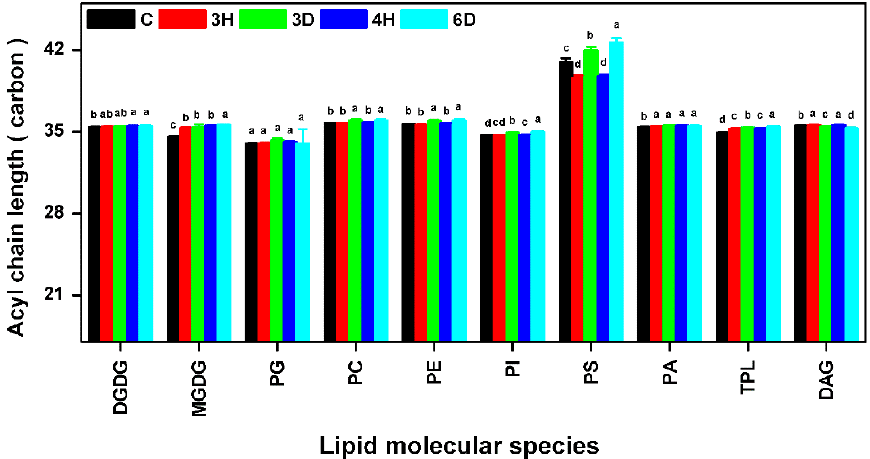
Figure 9. Acyl chain lengths (ACLs) of glycerolipids in the A. thaliana seeds during the hydration–dehydration cycles. The treatment was the same as that described in Figure 3. TPL, Total polar lipids. Each value is mean ± SD ( n = 4 or 5). Bars for the same lipid class with different letters indicate that the values were significantly different ( p < 0.05).